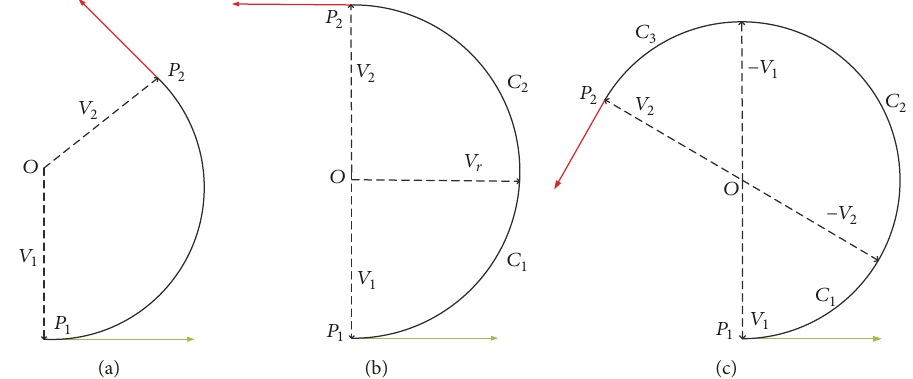
Figure 3: Different types of 𝐶 segments. (a) The minor 𝐶 segment; (b) the semicircular 𝐶 segment; (c) the major 𝐶 segment.